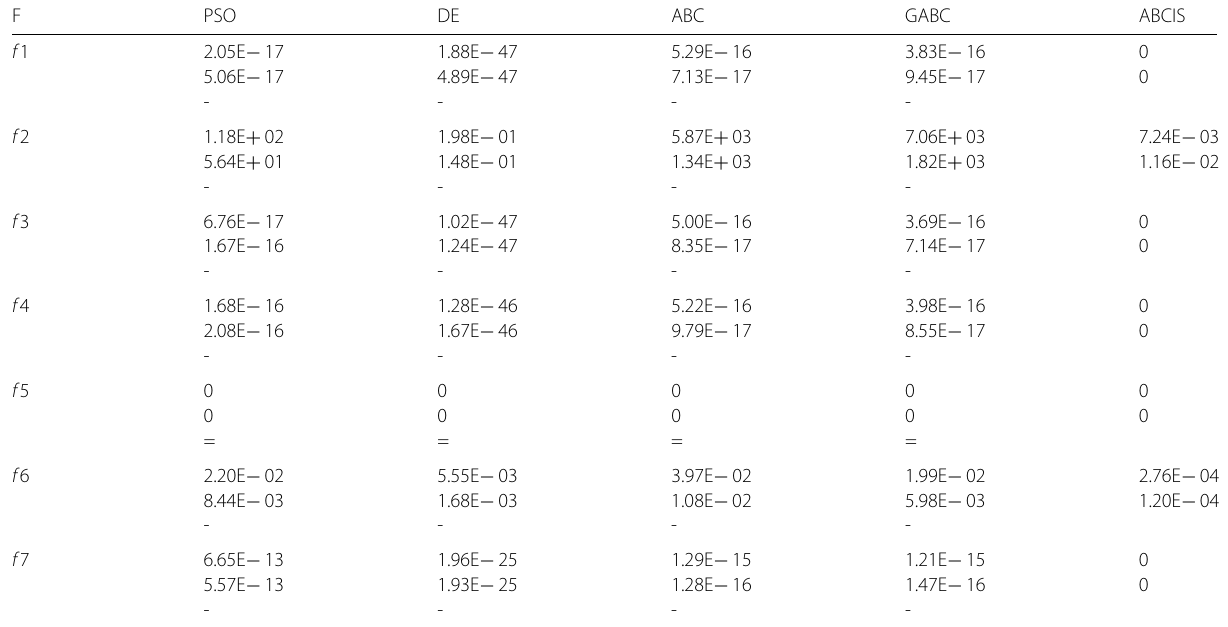
Table 3 Comparison results, D =